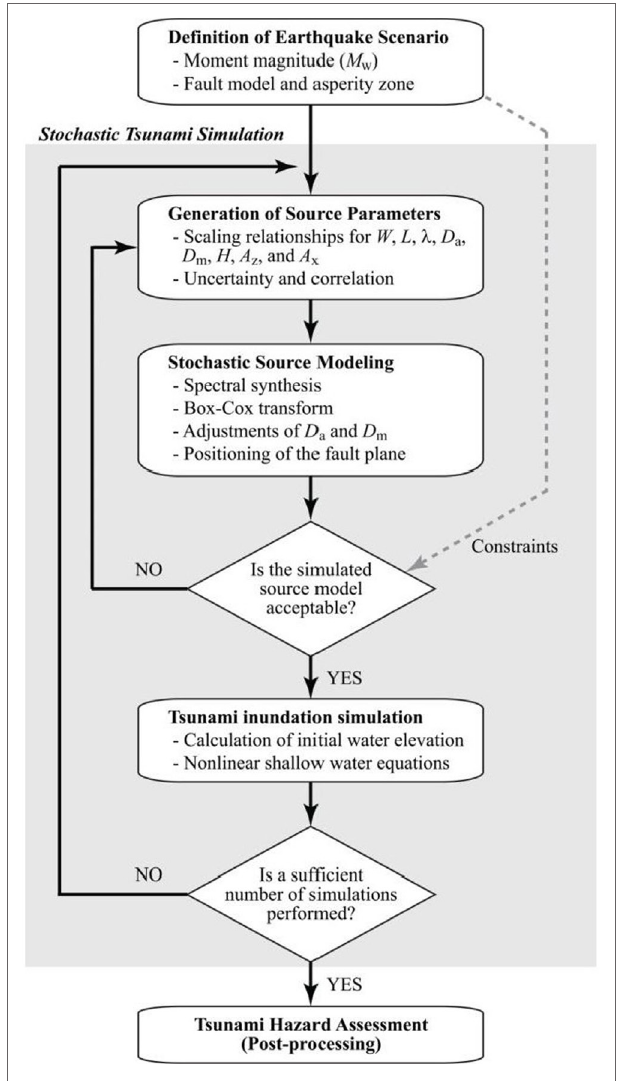
FigUre 5 | Flowchart of stochastic tsunami